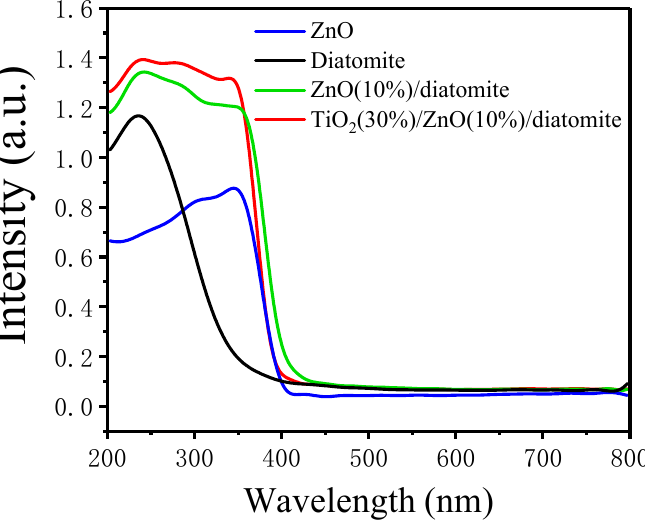
Figure 5. UV–vis spectra of diatomite, ZnO, ZnO(10%)/diatomite, and TiO 2 (30%)/ZnO(10%)/diatomite.